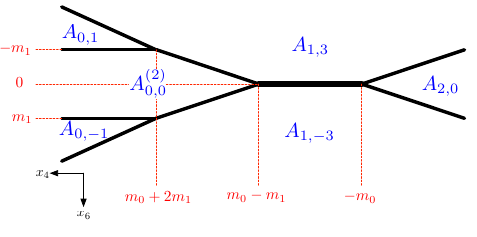
Figure 33. The regions for the largest A ( m ) Region 13 of the E 2 theory.